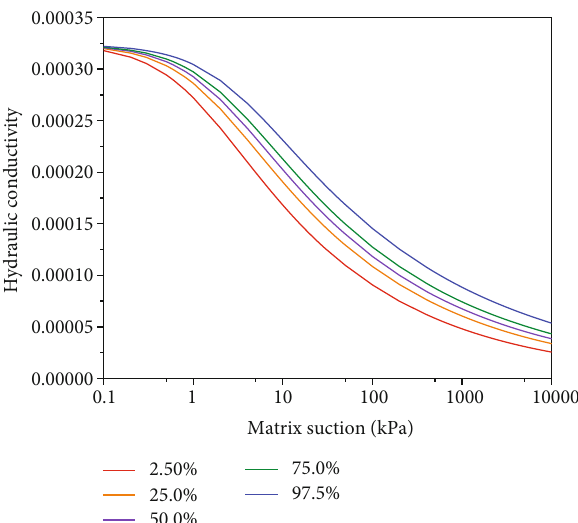
Figure 7: Soil hydraulic conductivity with di ff erent percentiles of the SWRC.